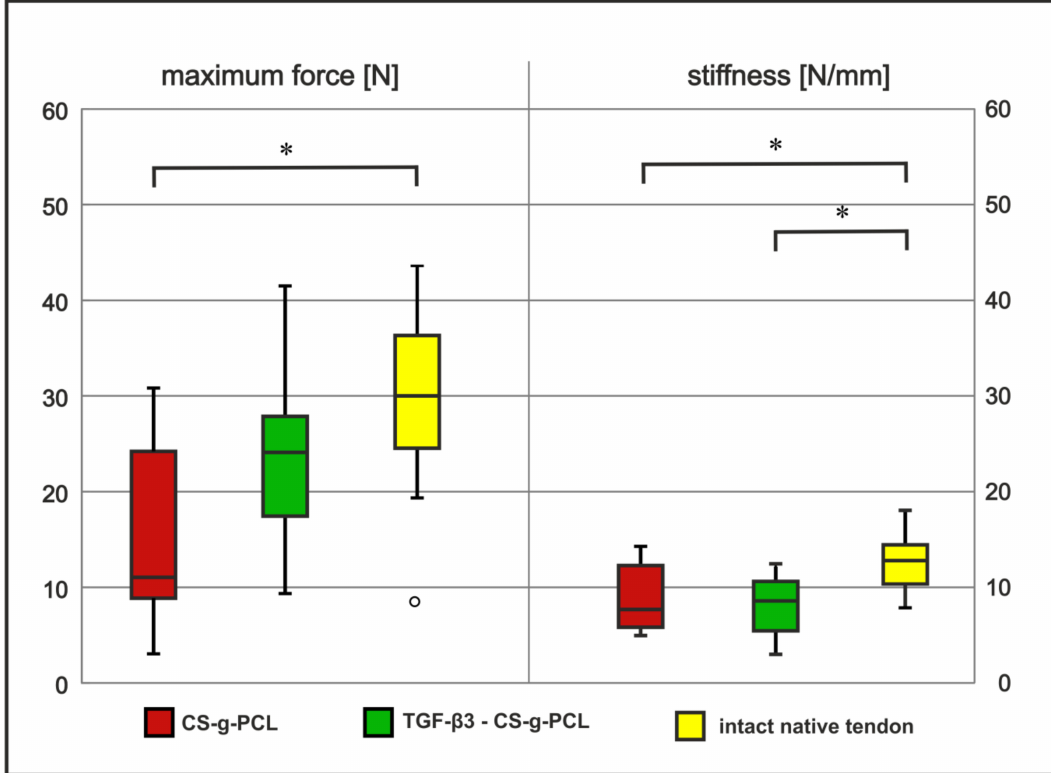
Figure 2. Di ff erences in median values of maximum forces (load to failure; left columns) and in sti ff ness (right columns) are shown for groups with refixed tendons (with CS–g–PCL sca ff old [red bars] and TGF– β 3–CS–g–PCL sca ff old [green bars]) compared to the intact native tendon [yellow bars]. Significant di ff erences (significance level of α = 0.05) are marked with asterisk (*).